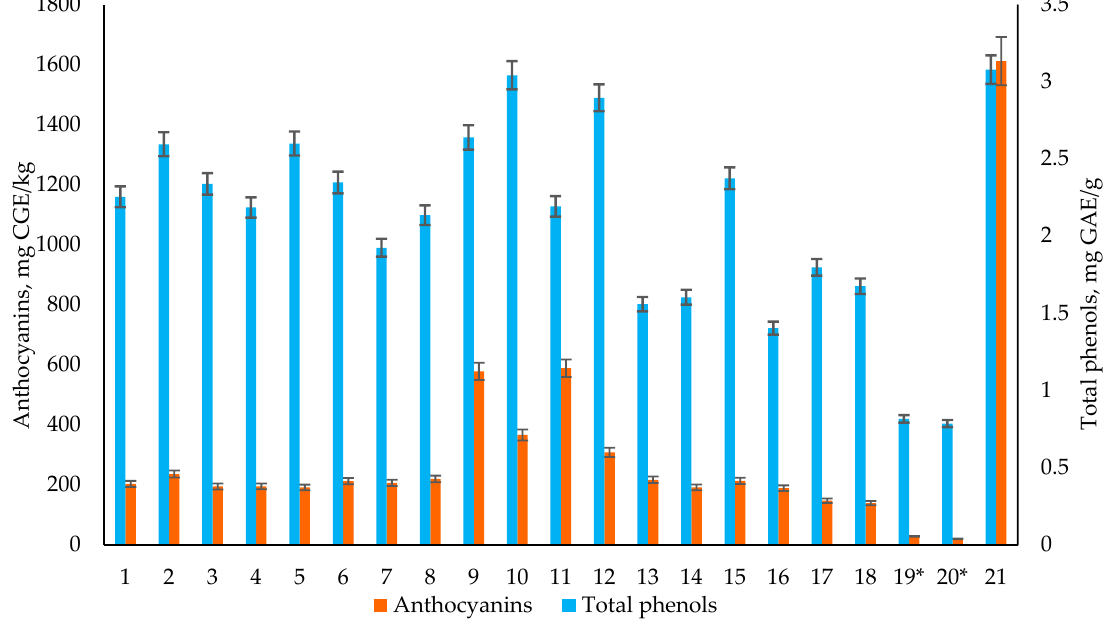
Figure 1. The concentrations of anthocyanins and total phenols in samples 1–21. All concentrations are given for dry weight. * p < 0.05 for total phenols and anthocyanin concentration between yellow-fleshed and colored potato tubers.